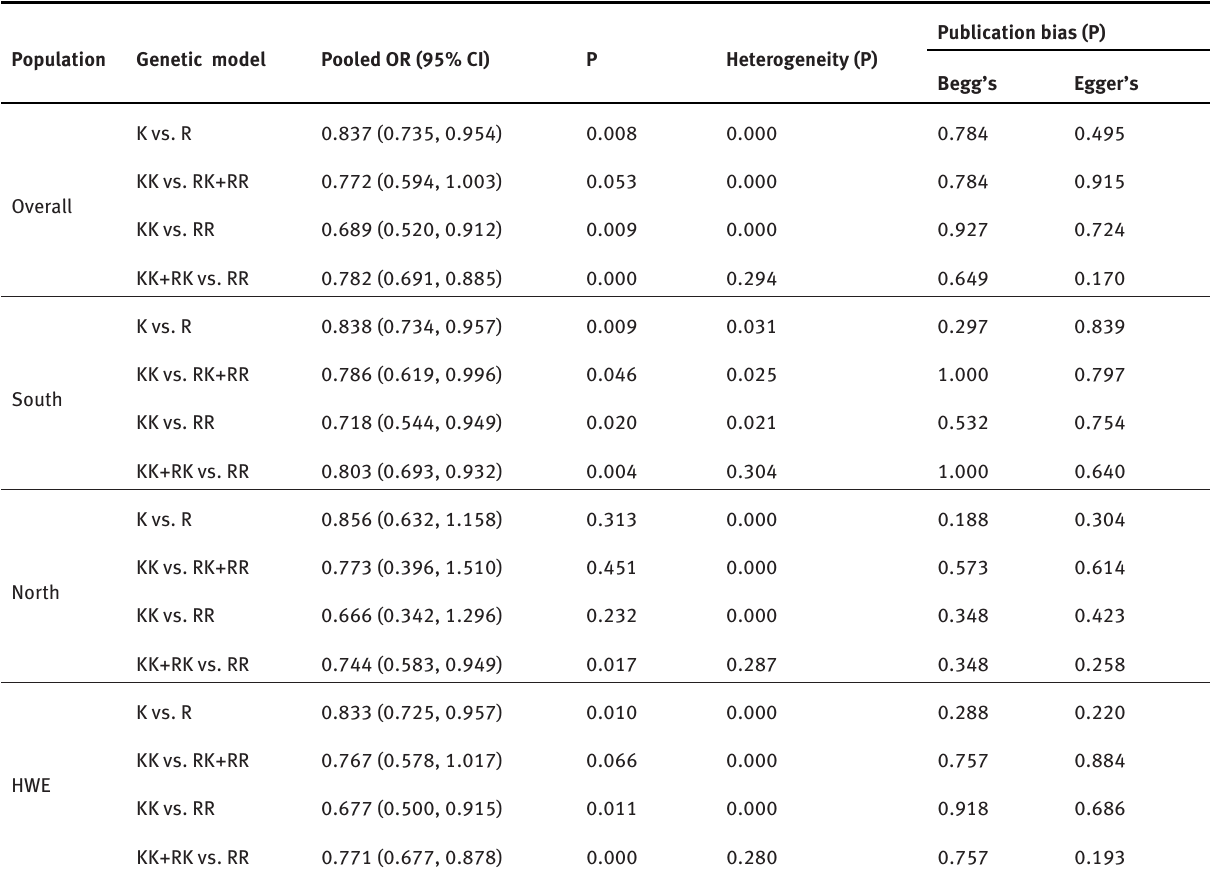
Table 2: Meta-analysis on the association between ABCA1 R219K and ischemic stroke